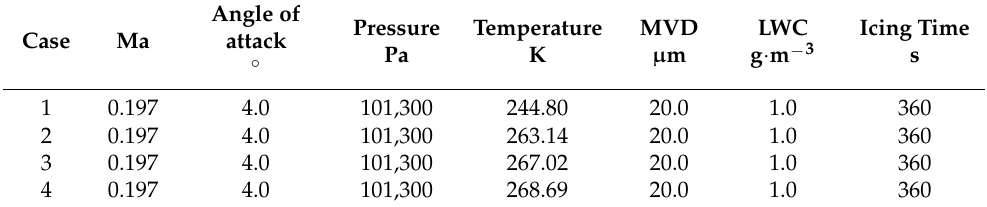
Table 1. Icing calculation